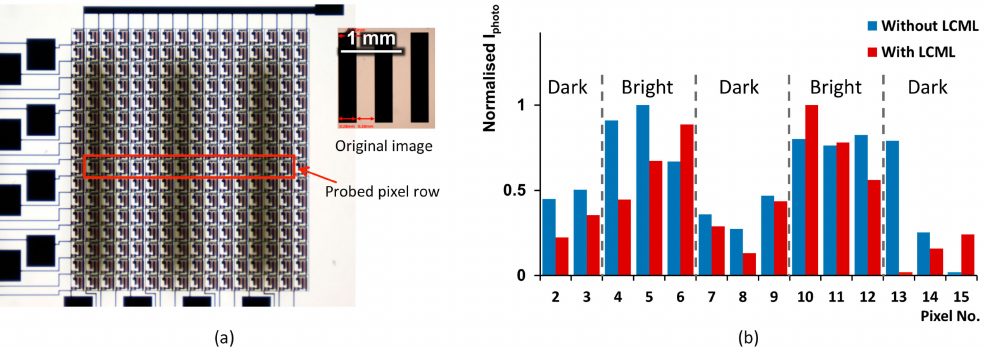
Figure 6. ( a ) A microscope image of the TFPT imager test setup with a line-pair test pattern of 1.8 lp/mm; ( b ) Normalised I photo values of pixels 2–15 in row No. 9 without and with the LCML